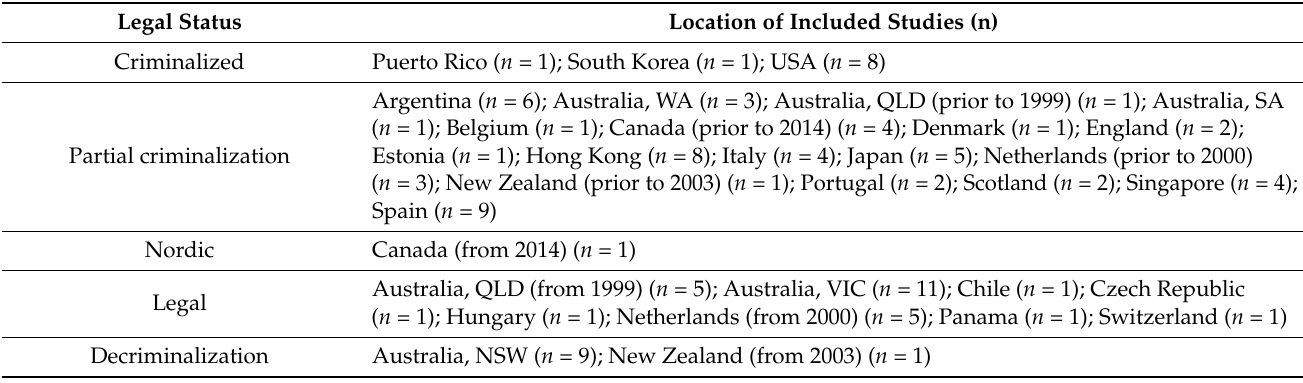
(Table S1: n = 10); partially criminalized (Table S2: n = 56); Nordic model (Table S3: n = 1); legalized (Table S4: n = 18; decriminalized (Table S5: n = 5) and multi-jurisdictional with differing legal statuses (Table S6: n = 5). Table 2. Summary of sex work legal status by study location and year of data